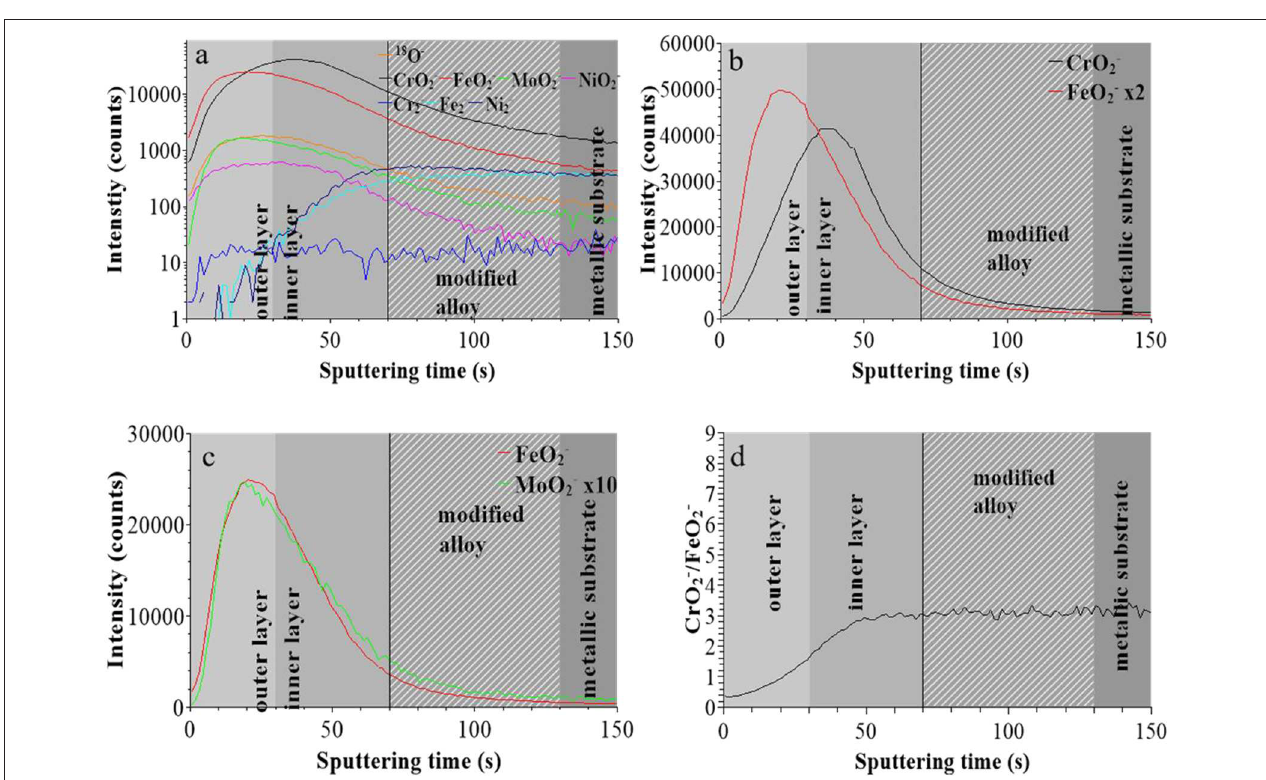
FIGURE 2 | ToF-SIMS depth profiles for the native oxide film on 316L SS: (a) 18 O − , CrO − 2 , FeO − 2 , NiO − 2 , MoO − 2 , Cr − 2 , Fe − 2 , and Ni − 2 secondary ions, (b) CrO − 2 and FeO − 2 secondary ions, (c) FeO − 2 and MoO − 2 secondary ions, (d) CrO − 2 / FeO − 2 intensity ratio.